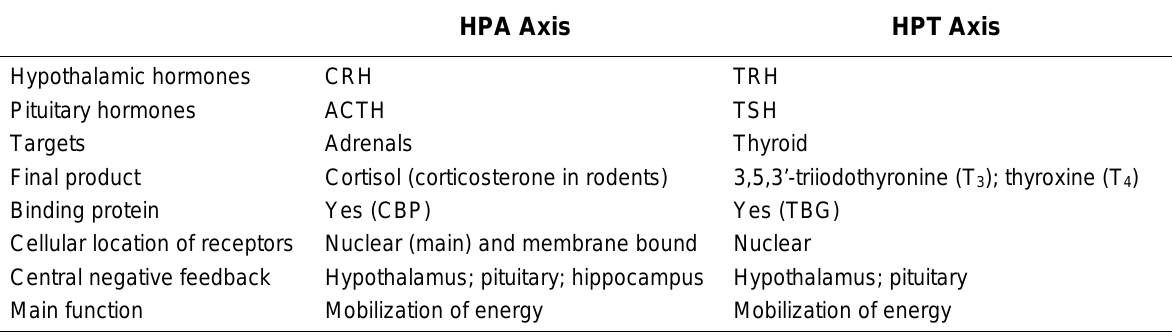
Common Features between HPA and HPT